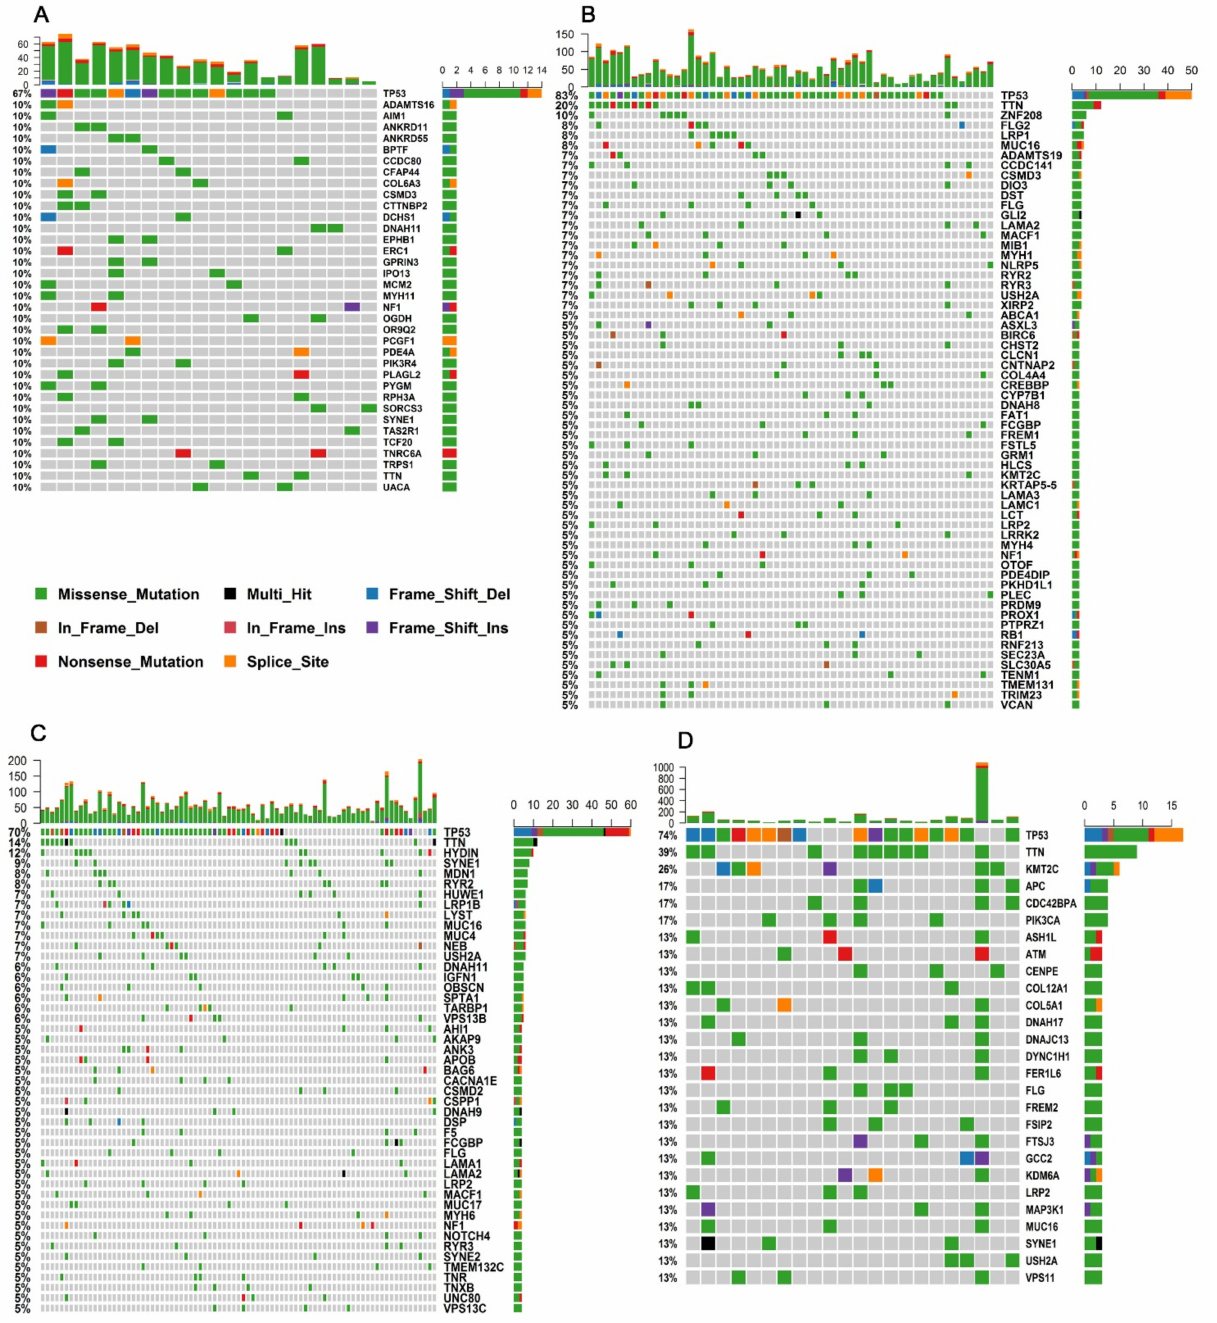
Figure 3. Most frequently affected genes: ( A ) Young HGSOC patients (20 samples shown); ( B ) elderly HGSOC patients; ( C ) young TNBC patients; ( D ) elderly TNBC patients. Each column represents a patient, and each line represents a gene. Considering the median number of CGC per sample, there was no difference between the young and elderly HGSOC patients ( n = 3, young vs. n = 4, elderly; ns). In contrast, a higher number of CGC per sample was detected in the elderly patients in the TNBC group ( n = 3, young vs. n = 6, elderly; p = 0.00013) (Table